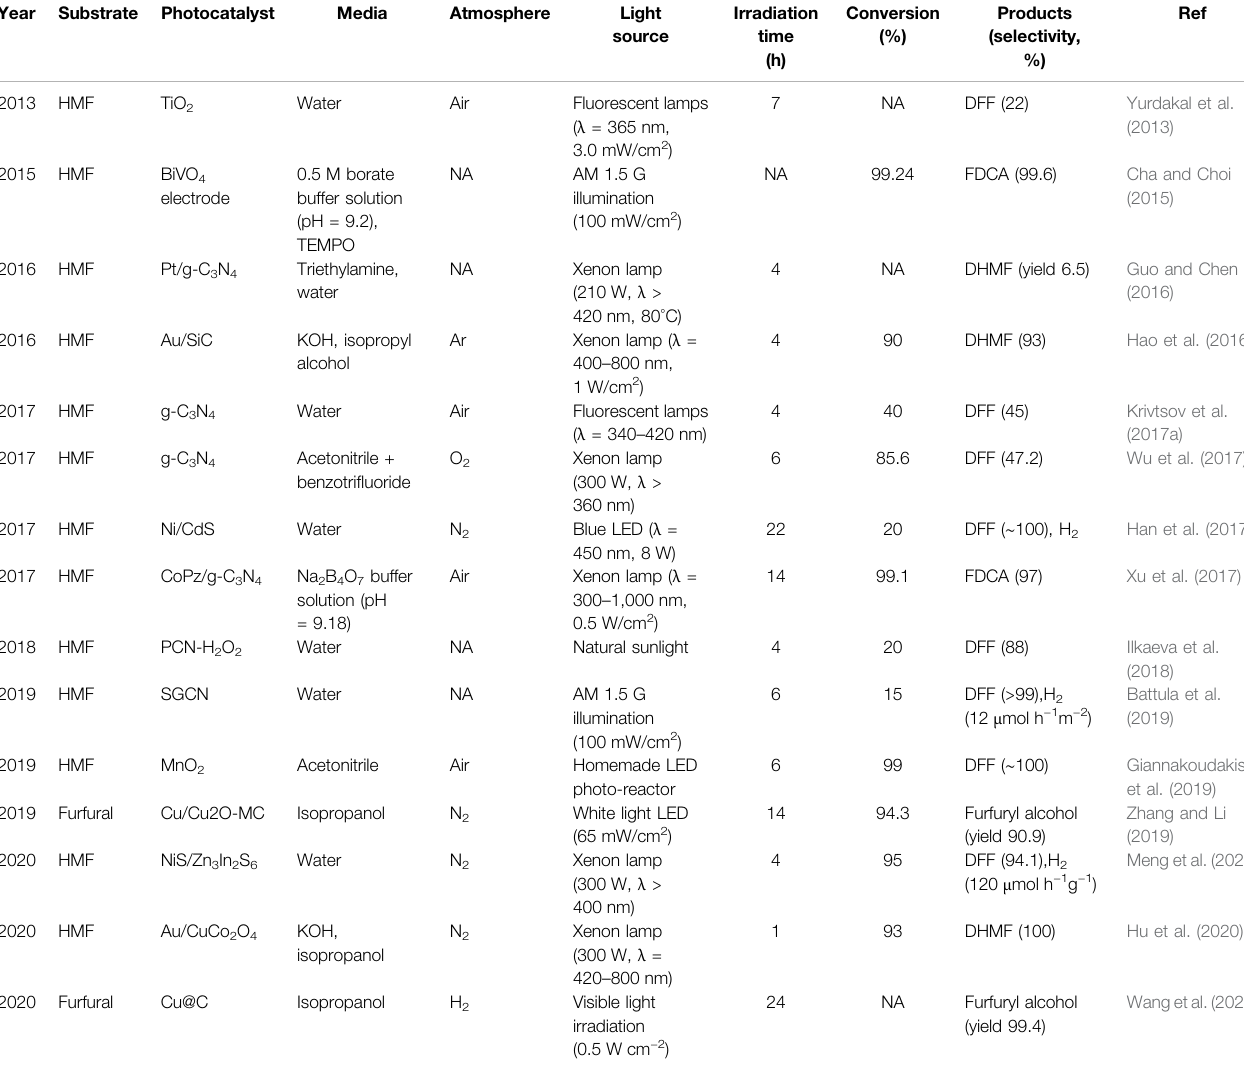
TABLE 3 | Photocatalytic conversion of HMF and furfural in the literature. Year Substrate